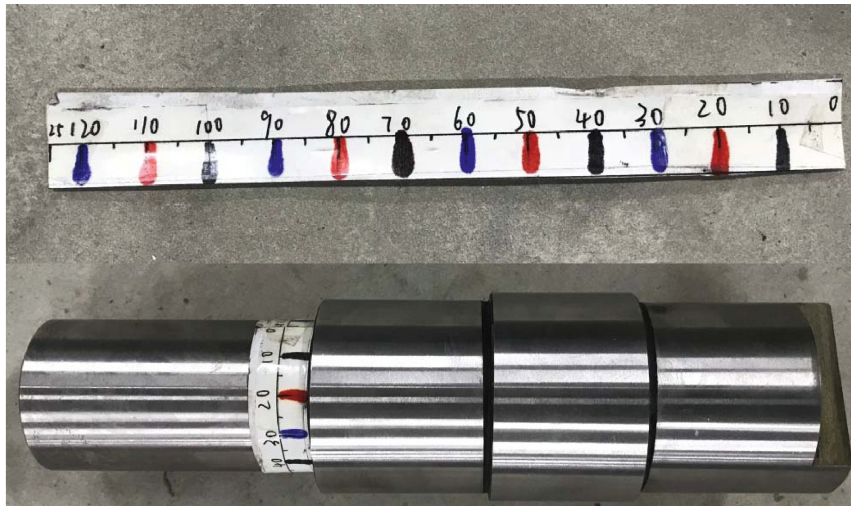
Figure 10: Scale plate on the